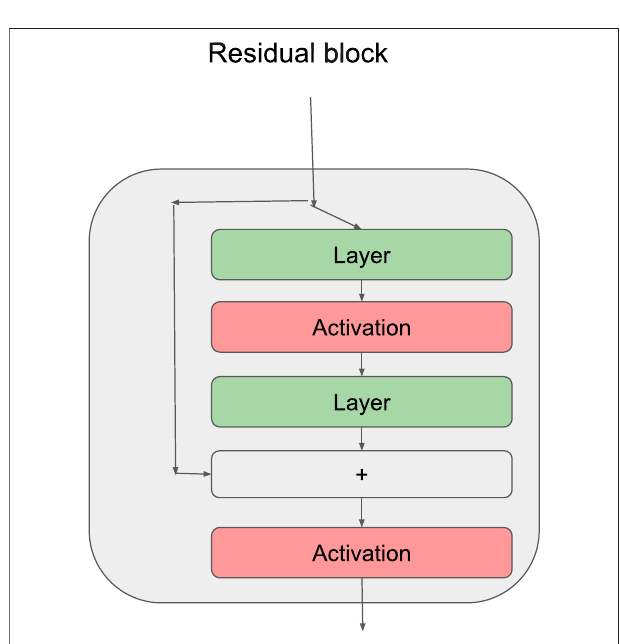
FIGURE 3 | Representation of a residual block, where two layers are